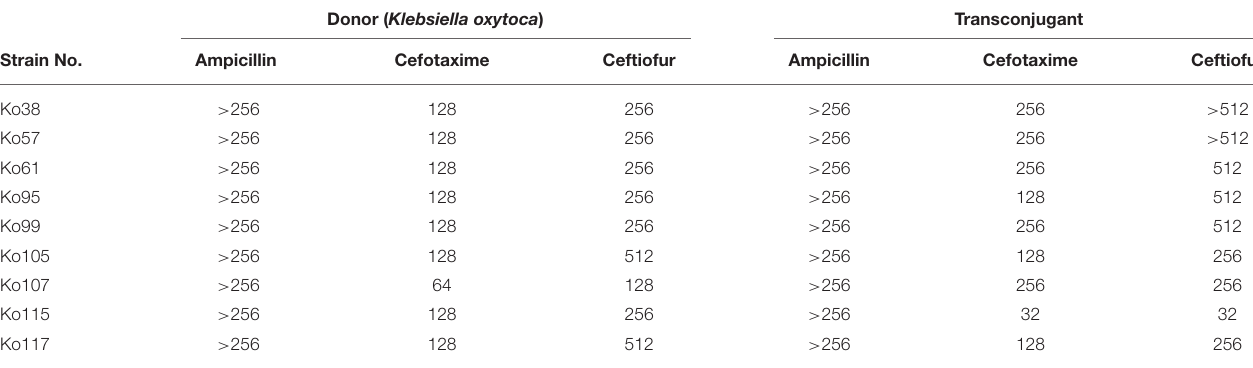
TABLE 3 | Minimal inhibitory concentrations ( µ g/mL) of β -lactams for donor ( Klebsiella oxytoca ; Ko) and transconjugant strains. Donor ( Klebsiella oxytoca ) Strain